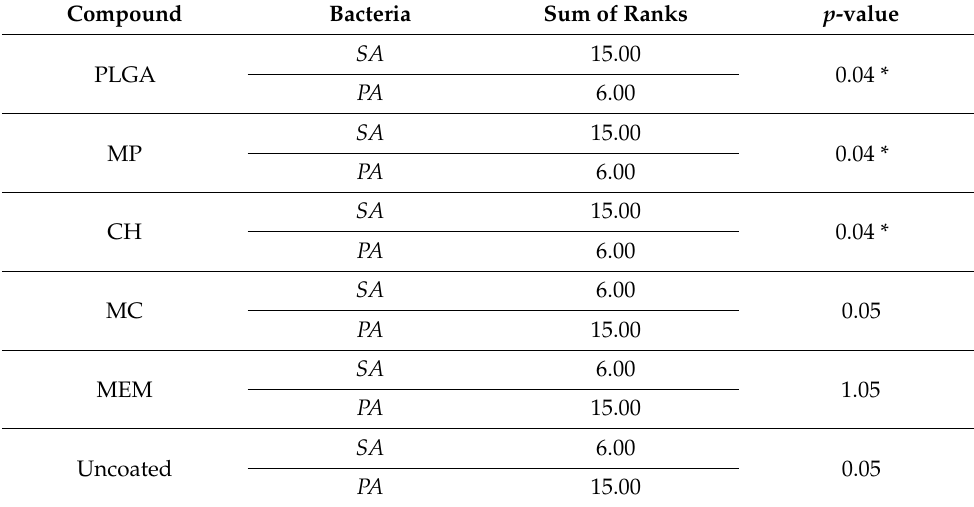
Table 2. Bacterial count within the different materials. Compound